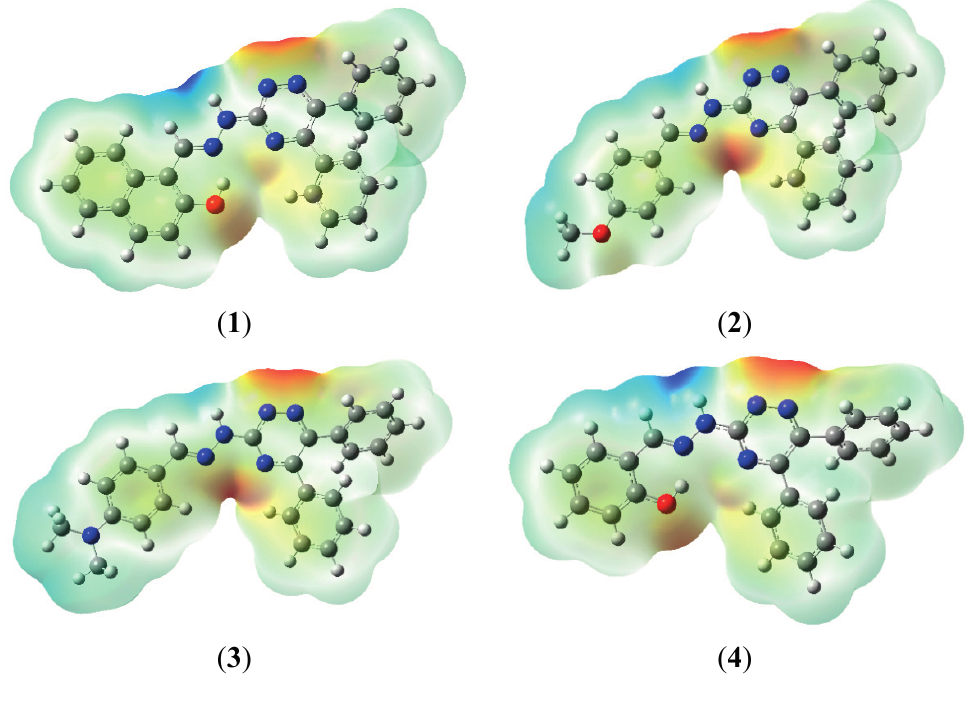
Figure 8. MEP surfaces of compounds 1 – 4